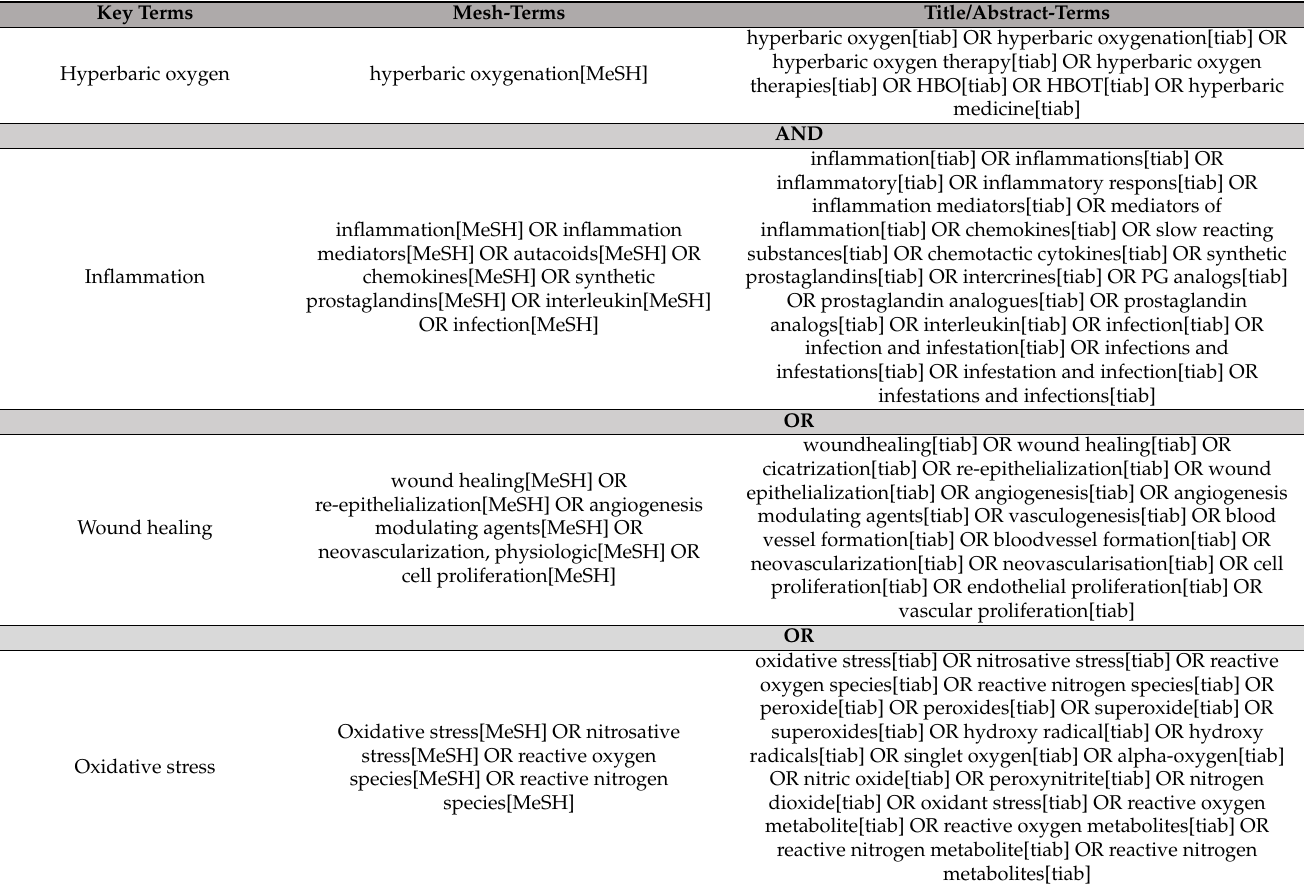
Table A1. Search strategy used in PubMed